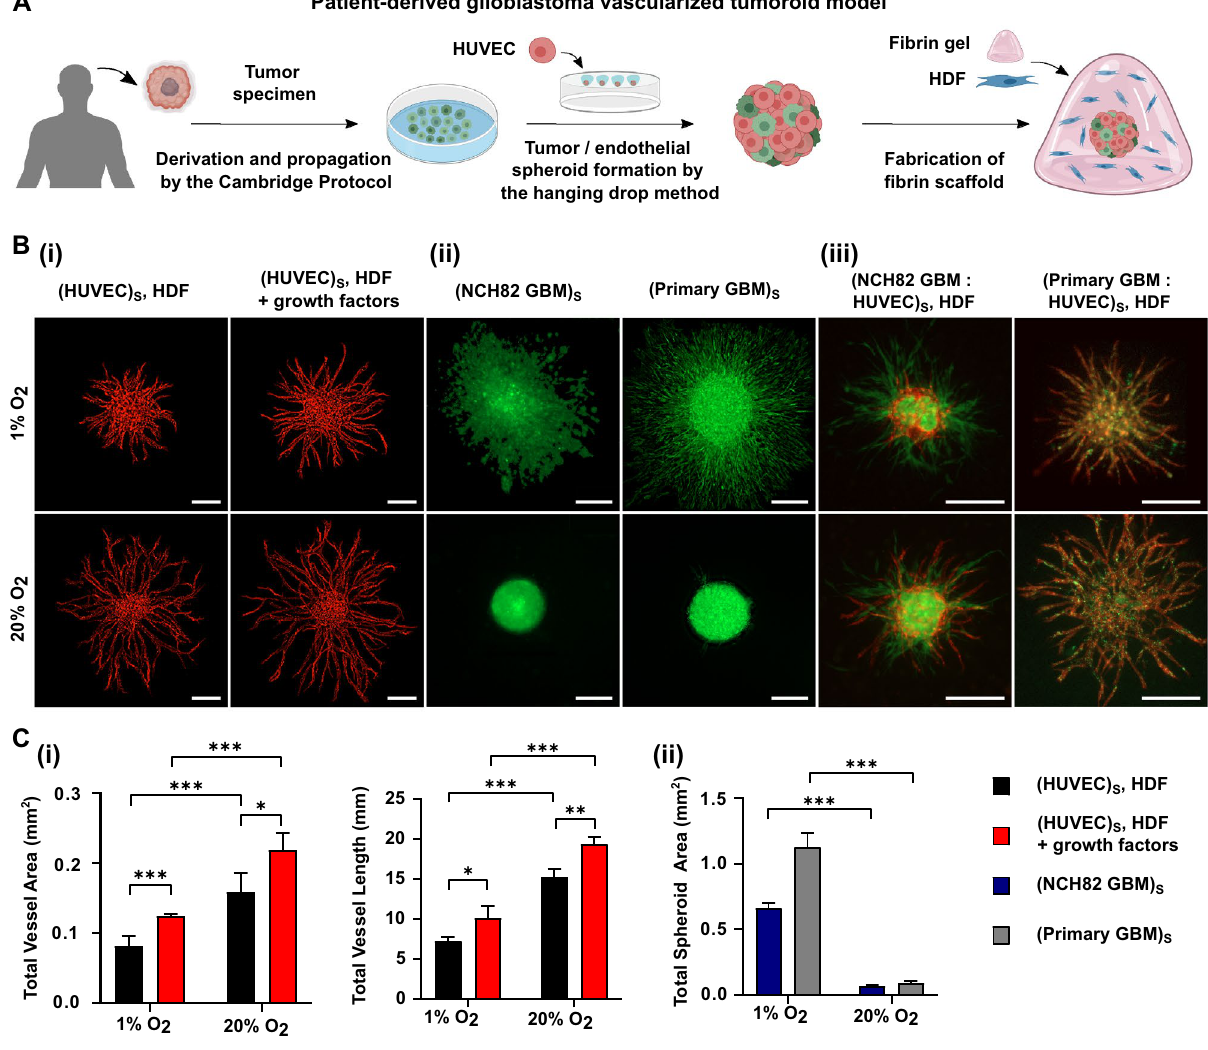
Figure 1. ( A ) Schematic representation of the formation of a vascularized tumoroid model from patient- derived primary glioblastoma cells. ( B ) Fluorescence images showing angiogenic sprouting at 1% and 20% O 2 at day 3 after seeding of (i) HUVEC (red) spheroid, supported by single HDF cells with or without additional growth factors; (ii) NCH82 (green) or primary (green) GBM spheroids and (iii) the full vascularized tumoroid model containing NCH82 or primary GBM : HUVEC spheroids with HDF supporting cells. HDF cells are non- fluorescent. The spheroids and single HDF cells are embedded in a 7.5 mg/mL fibrin gel. The scale bars represent 250 µ m. ( C ) Graphical representations of (i) the total vessel area and vessel length for HUVEC spheroids surrounded by HDF, with or without additional growth factors and (ii) the total spheroid area for NCH82 or primary GBM spheroids. Data are presented as the mean ± standard deviation; n = 3; * p < 0.05, ** p < 0.01, *** p < 0.001. Subscript S denotes cells seeded in the same